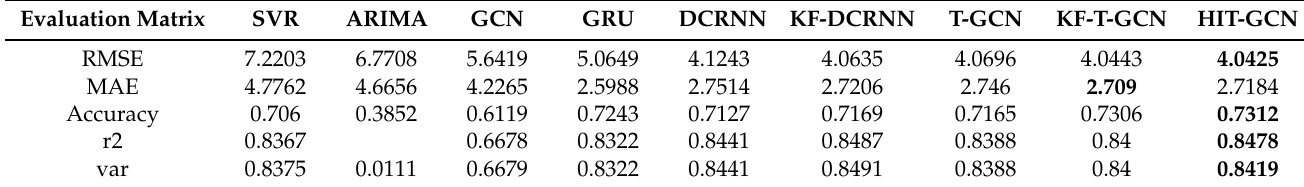
Table 1. Accuracy error comparison chart.